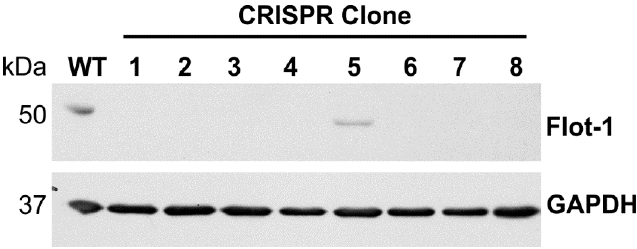
Figure 1. Preliminary Western Blot analysis of Hela flotillin-1 knockout clones. GAPDH was used as a loading control.